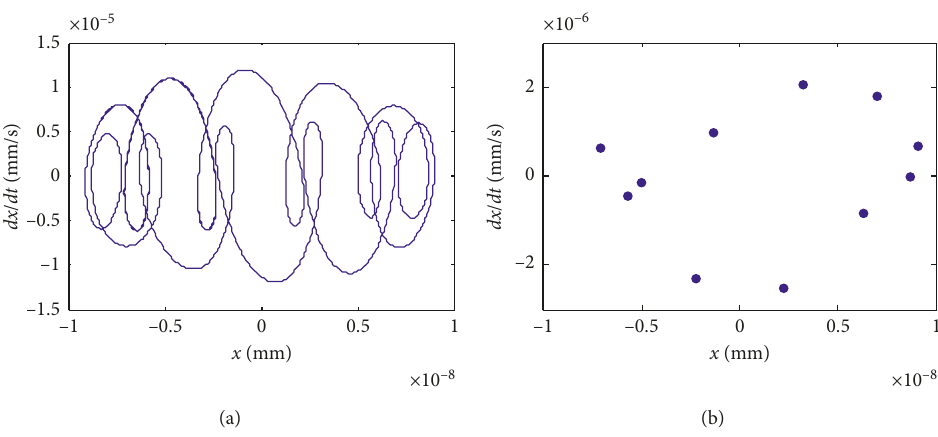
Figure 3: System response for ω � 5000r/min. (a) Phase portraits. (b) Poincar´e map.